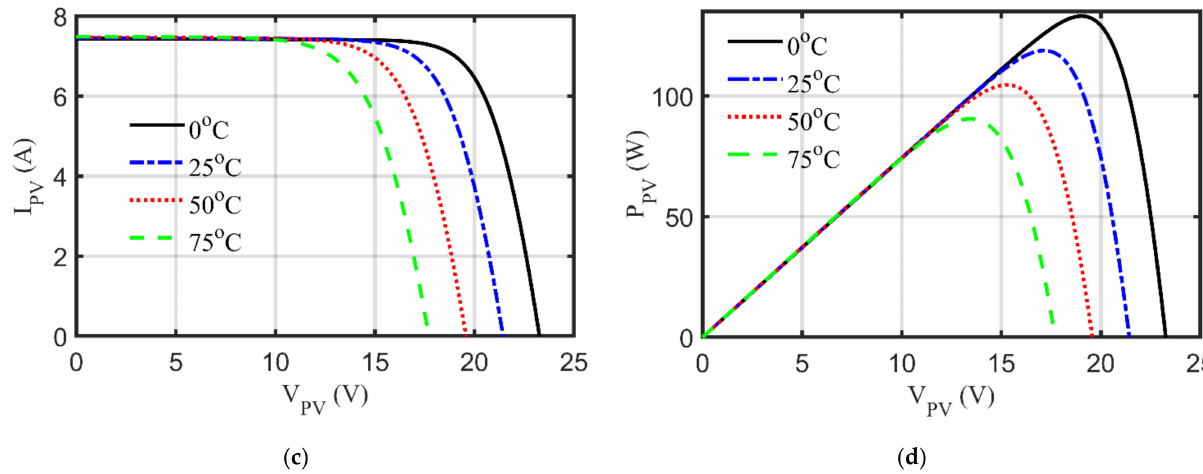
Figure 10. Principal characteristics of STP6 − 120 under variables G and T: ( a ) I-V patterns at varied G; ( b ) P-V patterns at varied G; ( c ) I-V patterns at varied T; ( d ) P-V patterns at varied